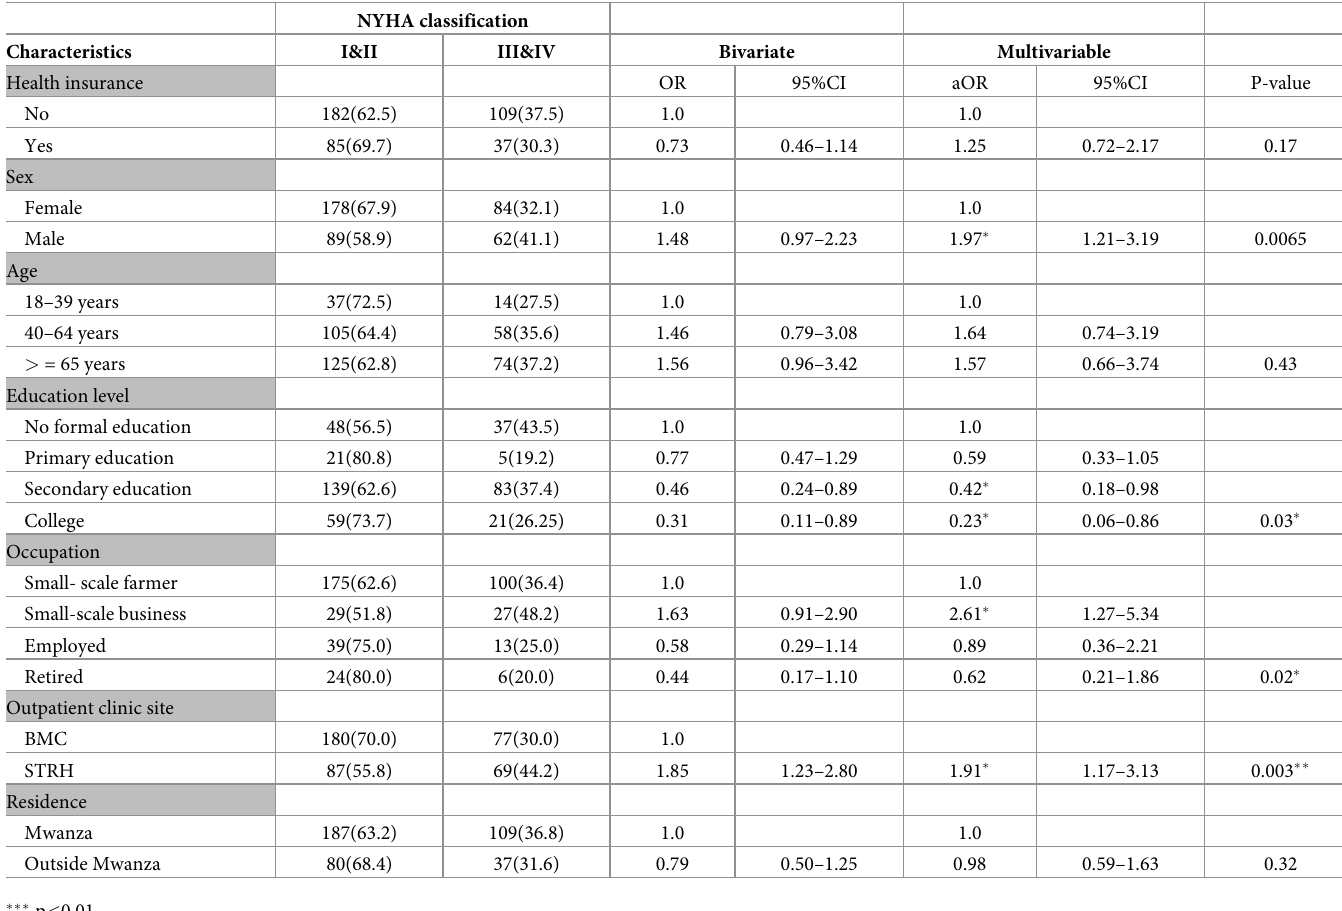
Table 2. Association between NYHA classification and health insurance status for heart failure patients in outpatient clinics at BMC and STRH in Mwanza,